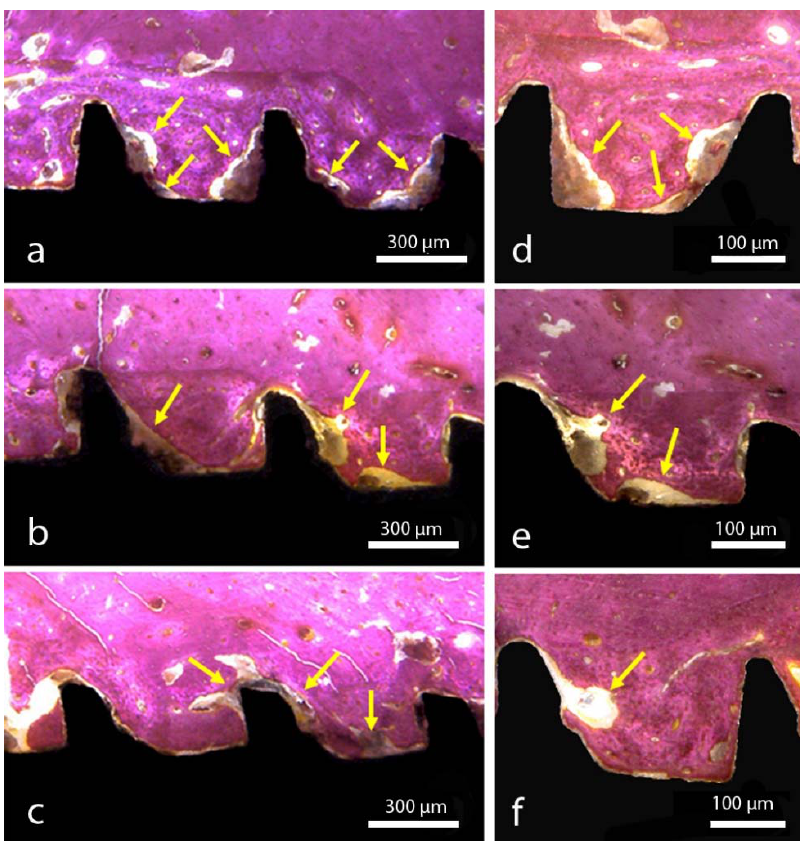
Figure 7. Survey of optical micrograph implant samples placed in different locations. An increase of connective tissue can be observed between ( a , d ) group G1, ( b , e ) group G2, and ( c , f ) group G3. The yellow arrows depict areas with connective tissue.